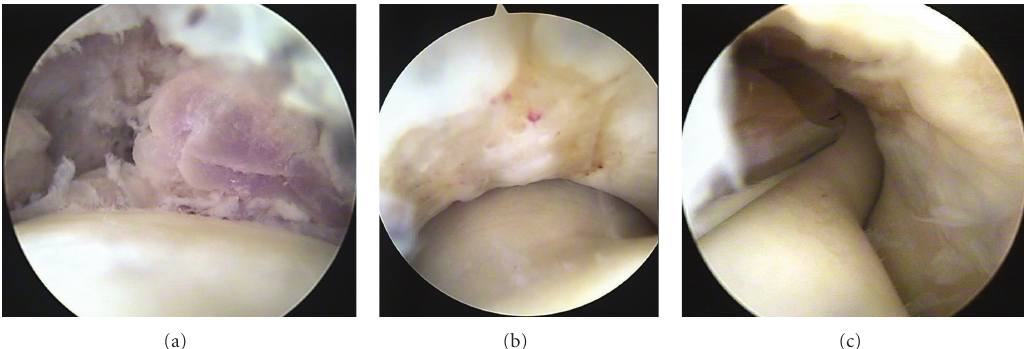
Figure 4: (a) Synovitis in the radiocapitellar joint. (b) Grade 2 chondral lesion on the trochlea. (c) Debridement and abrasion chondroplasty of the lesion with a